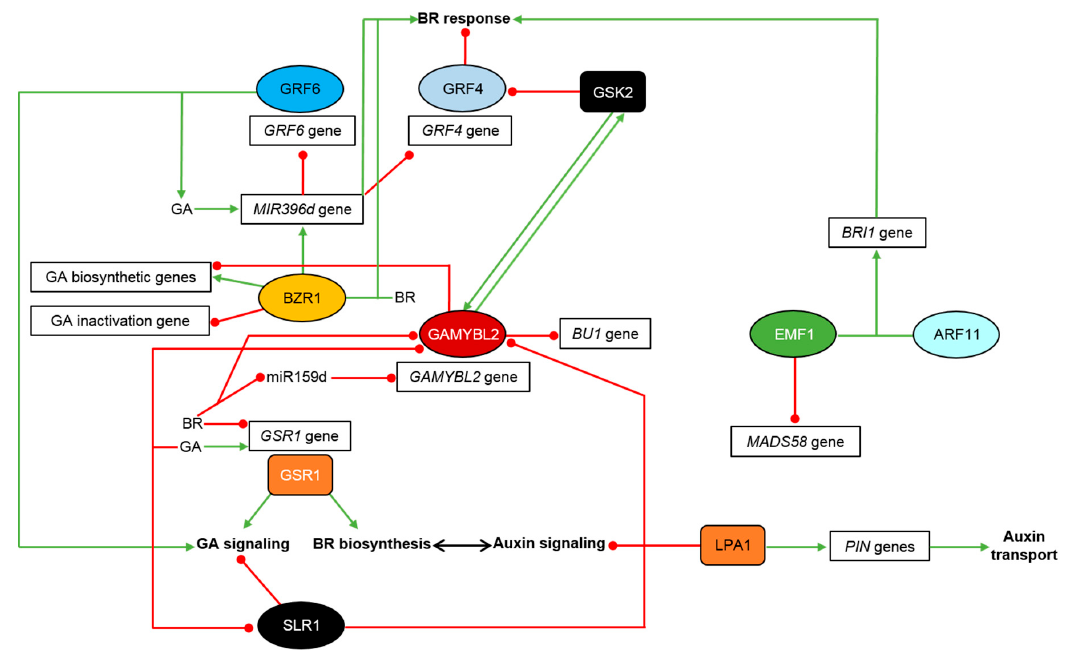
Figure 3. Molecular mechanism of crosstalk between the BR, auxin and GA signaling pathways which enables regulation of various physiological and developmental processes in rice and other monocots. Transcription factors are shown as ovals, other proteins are depicted as rectangles. Green arrows indicate stimulation, whereas red lines with the bullet points represent suppression. Detailed description is given in the text.